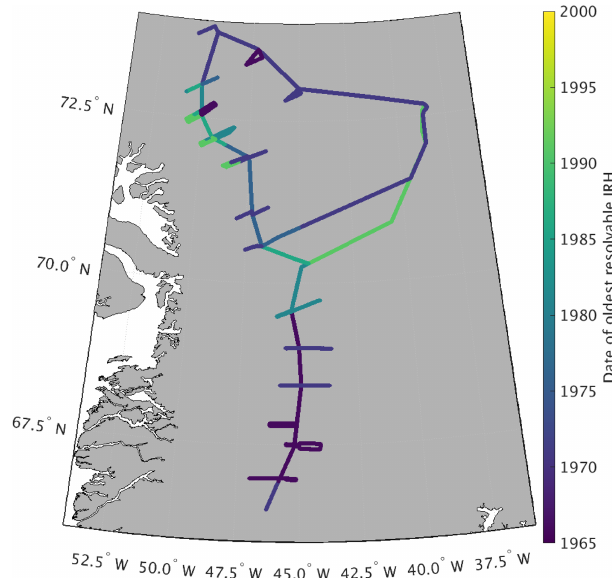
Figure 3. Date of oldest resolvable internal reflecting horizon throughout the entire GreenTrACS traverse route. Anomalously young ages from Core 7 to Summit are due to equipment malfunc-